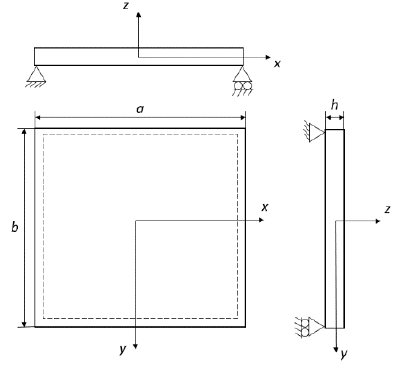
Figure 3. Representation of the quadrilateral plate.